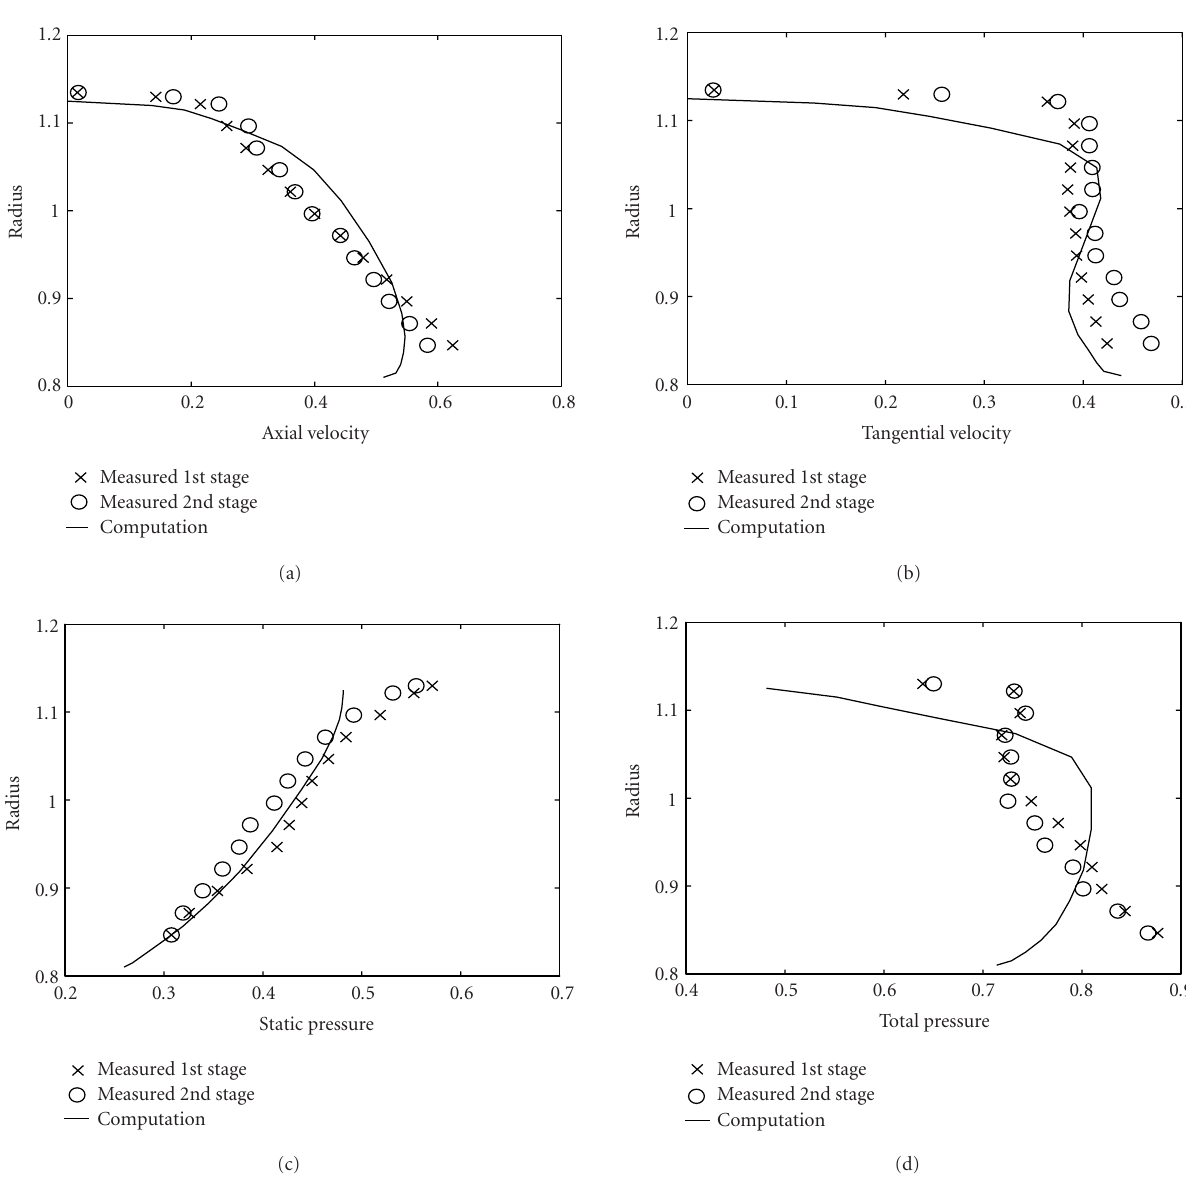
Figure 3: Nondimensional impeller results, downstream